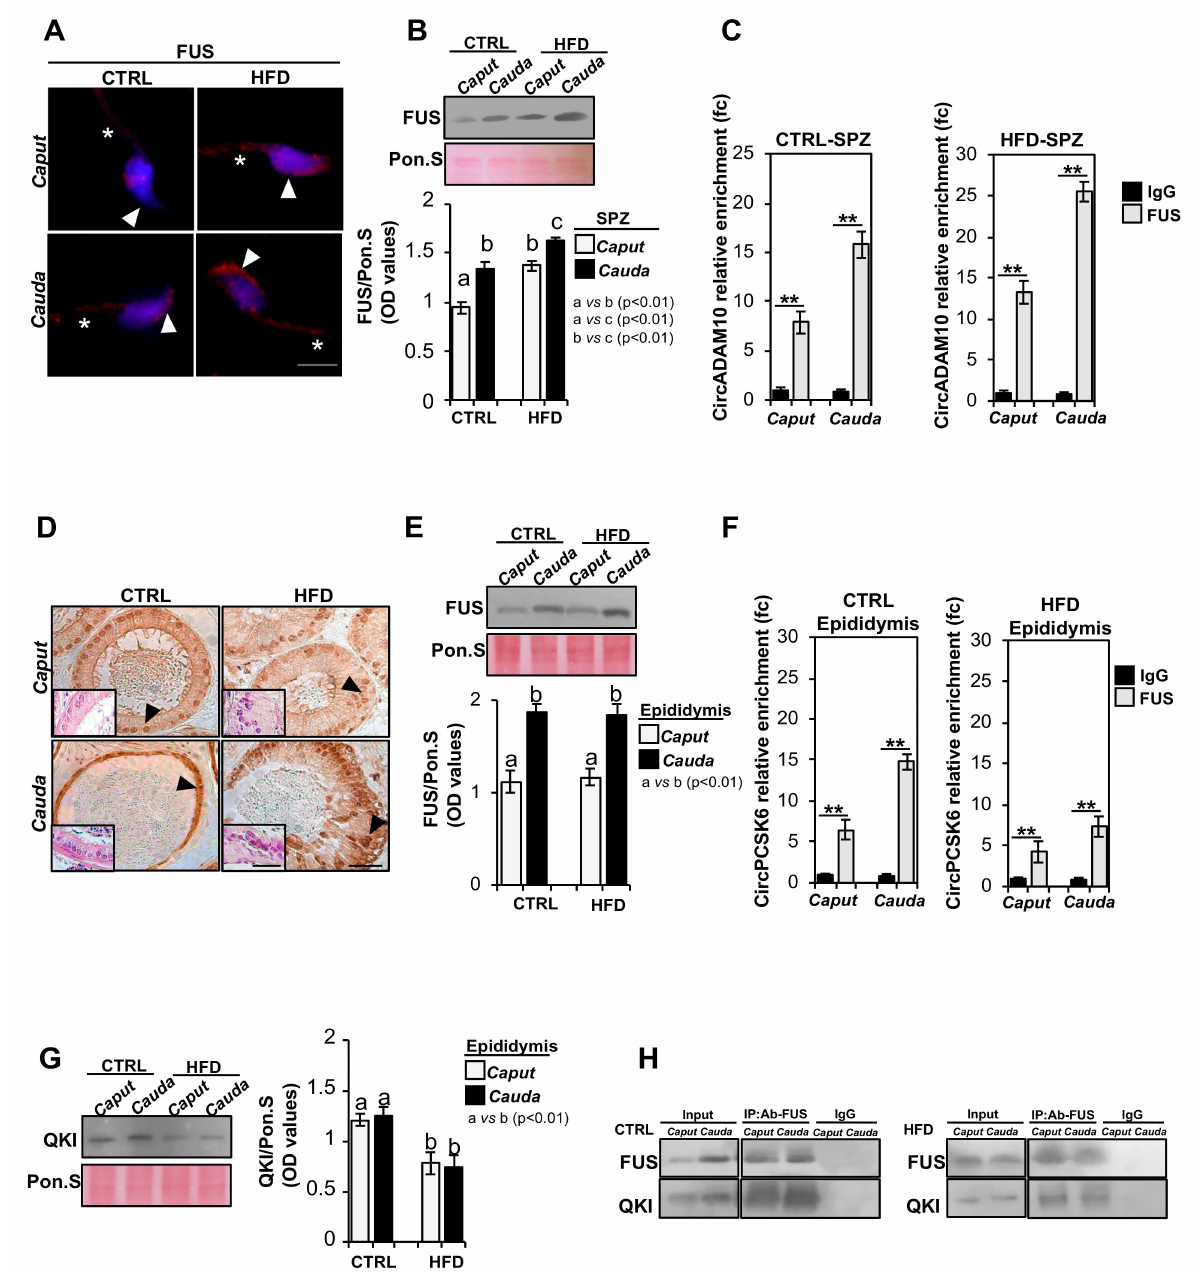
Figure 5. Characterization of backsplicing machinery in SPZ and epididymis of CTRL and HFD mice. ( A ) Immunofluorescence analysis of FUS protein in caput and cauda SPZ of CTRL and HFD mice. White arrowheads and white asterisks represent FUS localization (RED) in sperm head and tail, respectively. Nuclei were labeled with DAPI (blue). Scale bar: 5 µ m. ( B ) Western blot analysis of FUS protein (75 KDa) in caput and cauda SPZ of CTRL and HFD mice (n = 5 different samples for each experimental group in triplicate). Signals were quantified by densitometry analysis and normalized to Ponceau Red (Pon.S). Data were expressed in OD values and reported as mean ± SEM. Experimental groups with statistically significant differences ( p < 0.01) were indicated with different letters. ( C ) The enrichment levels of circADAM10 in the products of RIP assay (FUS-IP compared with IgG-IP) in caput and cauda SPZ of CTRL and HFD mice detected by qRT-PCR. Data are reported as mean ± SEM from three independent experiments. ** p < 0.01. ( D ) Immunocytochemistry of FUS in Bouin’s fixed caput and cauda epididymis sections (7 µ m) of CTRL and HFD mice (n = 5 different samples for each experimental group in triplicate). The FUS protein localization in principal cells